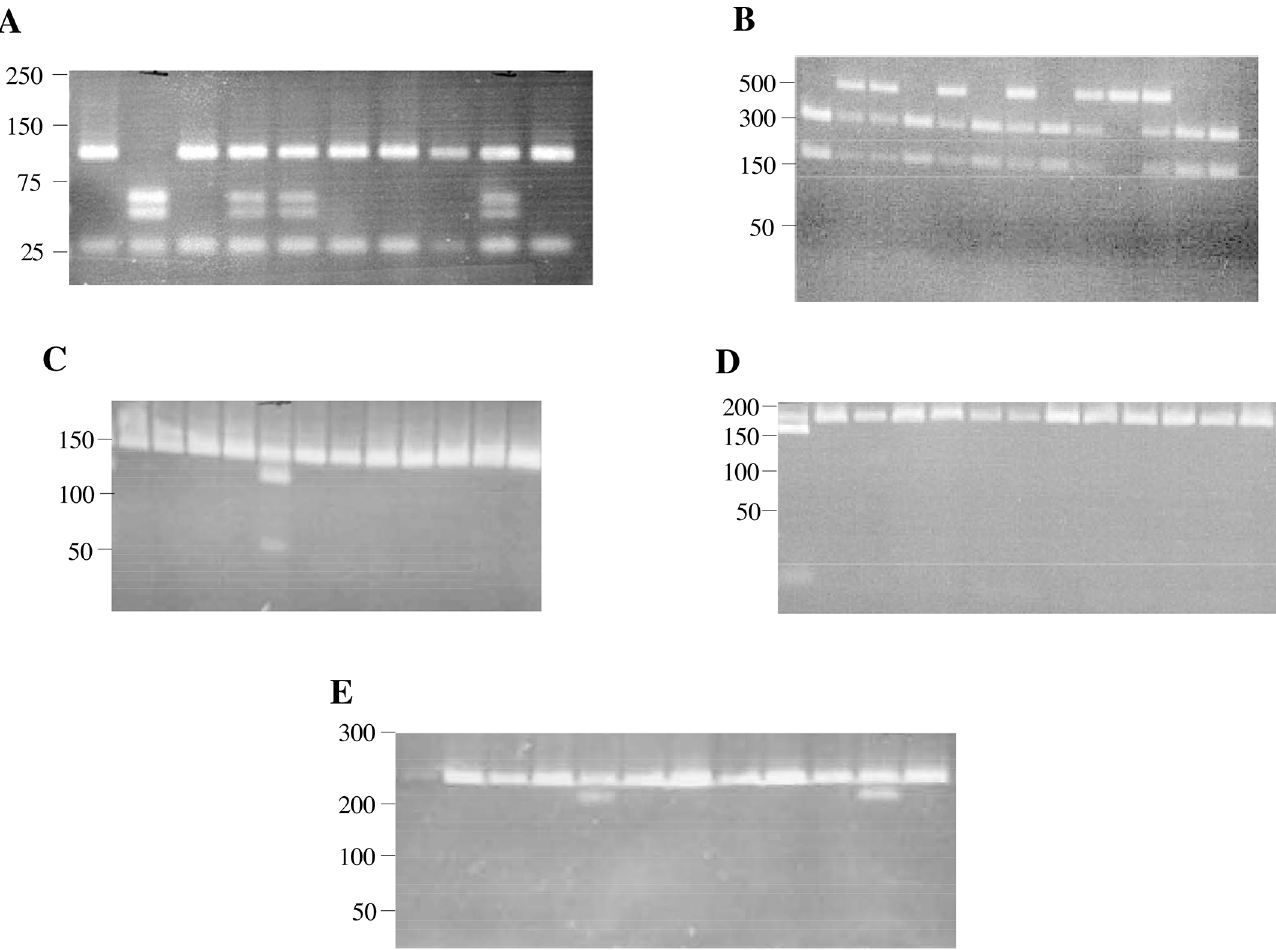
Fig 1. Single nucleotide polymorphisms of TLR ’ s. PCR-based RFLP ’ s were performed with genomic DNA from each participant. Representative agarose gels of shown for: TLR9 (T1237C) (Panel A), TLR9 (T1486C) (Panel B), TLR4 (Thr399Ile) (Panel C), TLR4 (Asp299Gly) (Panel D) and TLR2 (Arg753Gln) (Panel E). Numbers in left margin of each gel correspond to DNA ladder base pairs. Lanes with restriction fragments for heterozygotes and homozygotes of each SNP are distinguishable from restriction fragments for wildtypes. Representative patient samples are shown in each lane of each panel.